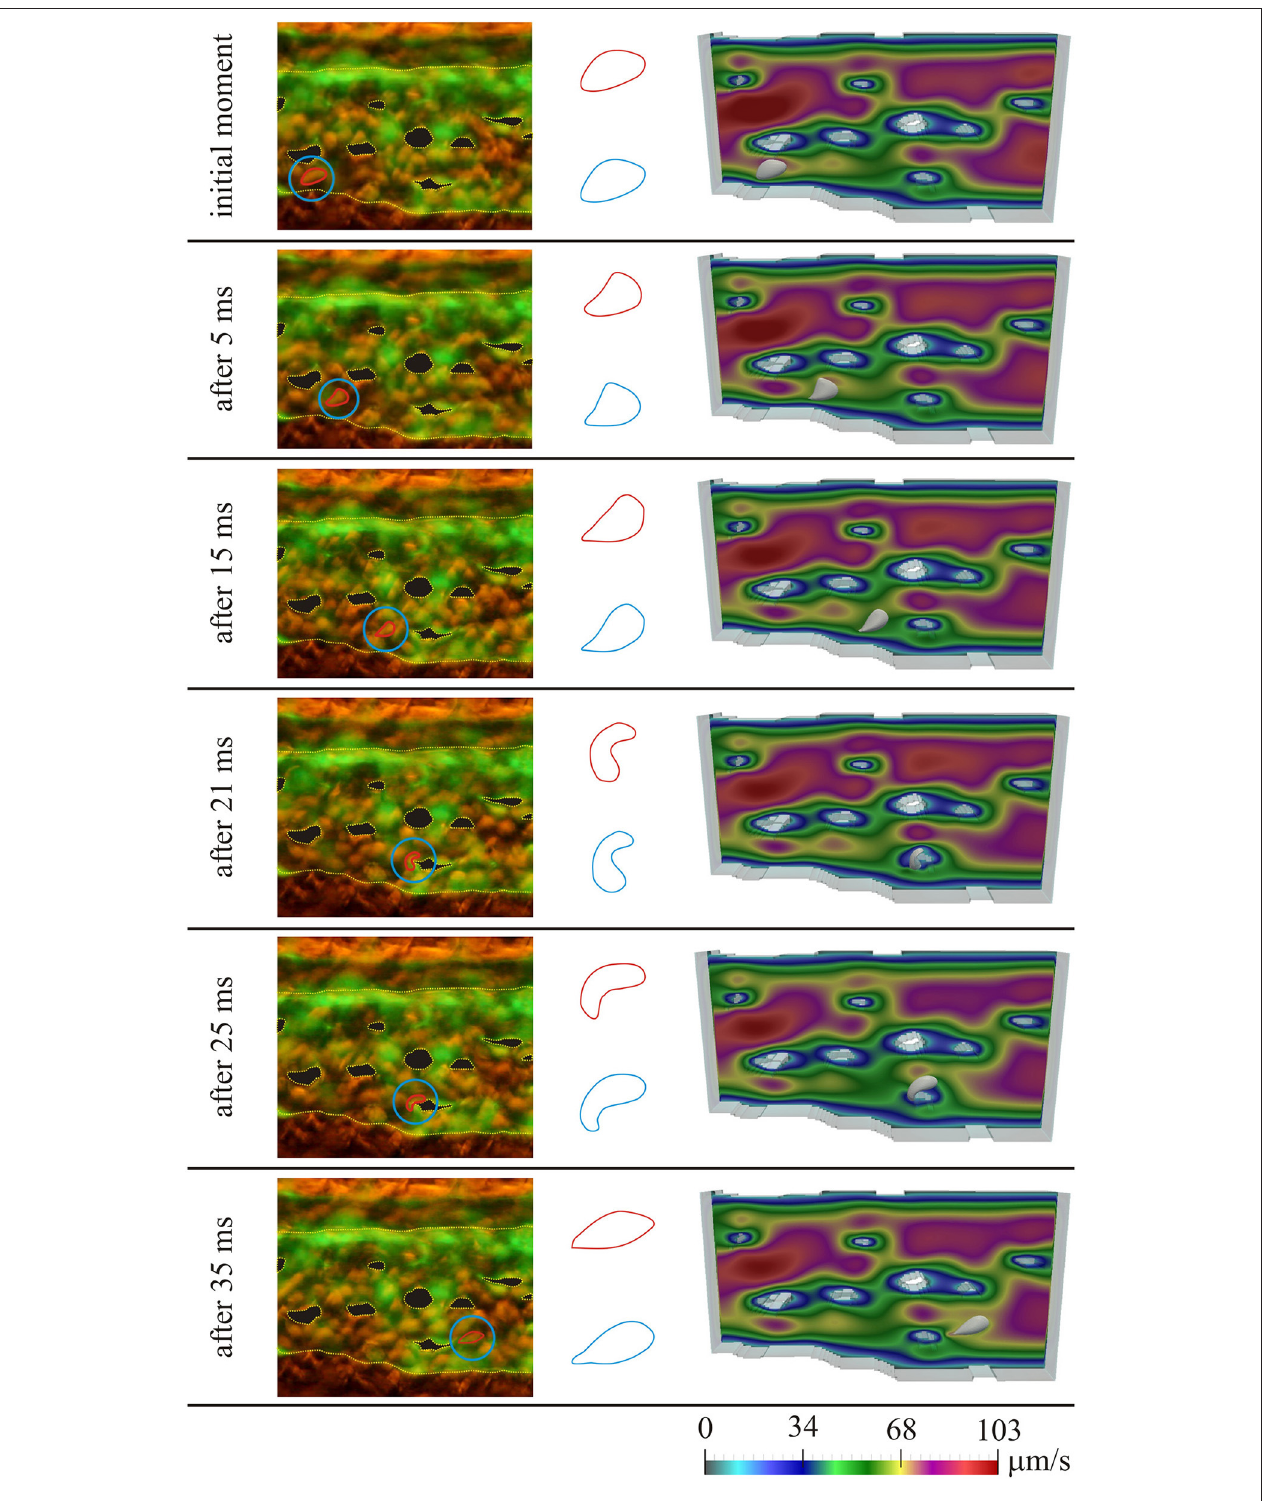
FIGURE 4 | Comparison of experimental results with results obtained using numerical simulation, for the second initial position of the RBC; left—microscopic image of the zebrafish, with denoted considered RBC; middle—isolated shapes of the considered RBC (red—experiment; blue—simulation); right—results obtained using numerical simulation. Colors on the images obtained using numerical simulations denote the intensity of the blood velocity, according to the scale bar at the bottom of the Figure. The blood flow through capillary plexus of the living zebrafish was observed 32h post fertilization.